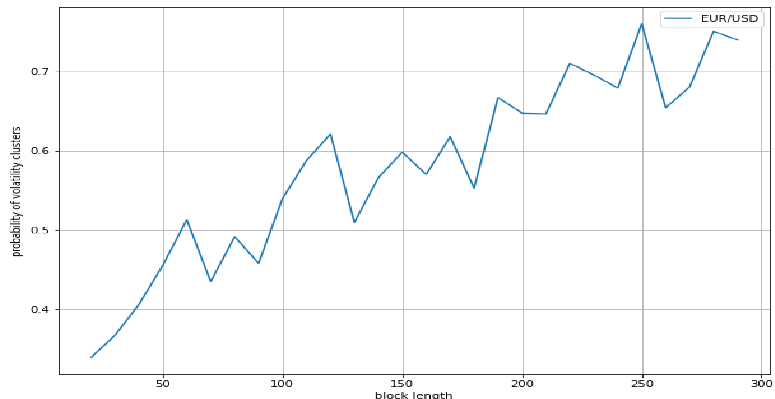
Figure 7. Probabilities of volatility clusters of the next assets. From top to bottom, an index (S&P500), a stock (Apple), and a forex pair (Euro/USD).